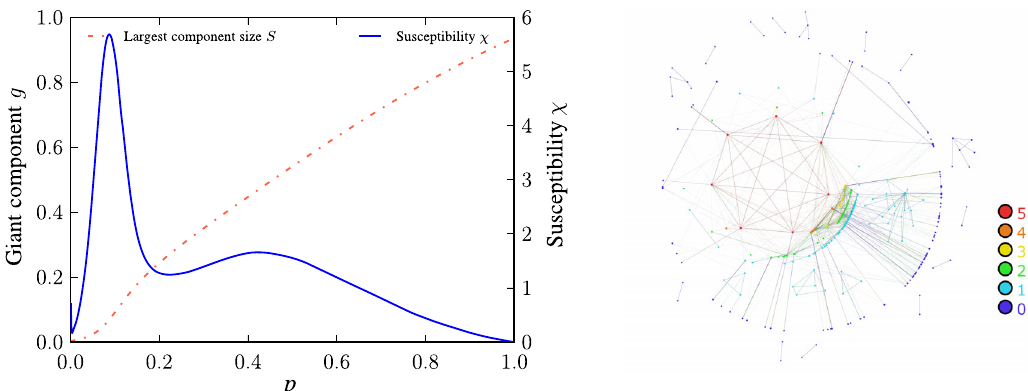
FIG. 11. Left panel: Bond percolation simulations for the US air transportation network. The relative size of the largest connected component g and its susceptibility χ as a function of the bond occupation probability p are shown. Right panel: m -core